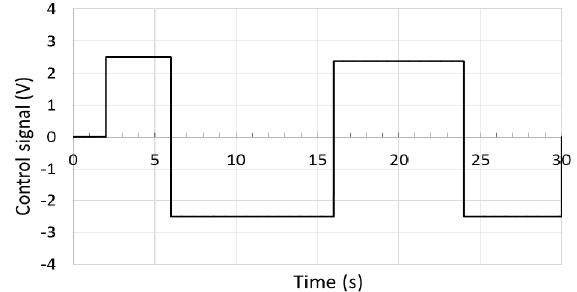
Figure 10. Control signal (electrical voltage) applied to the pump swash plate for experimental evaluation of the circuit with POCVs and the proposed circuit.